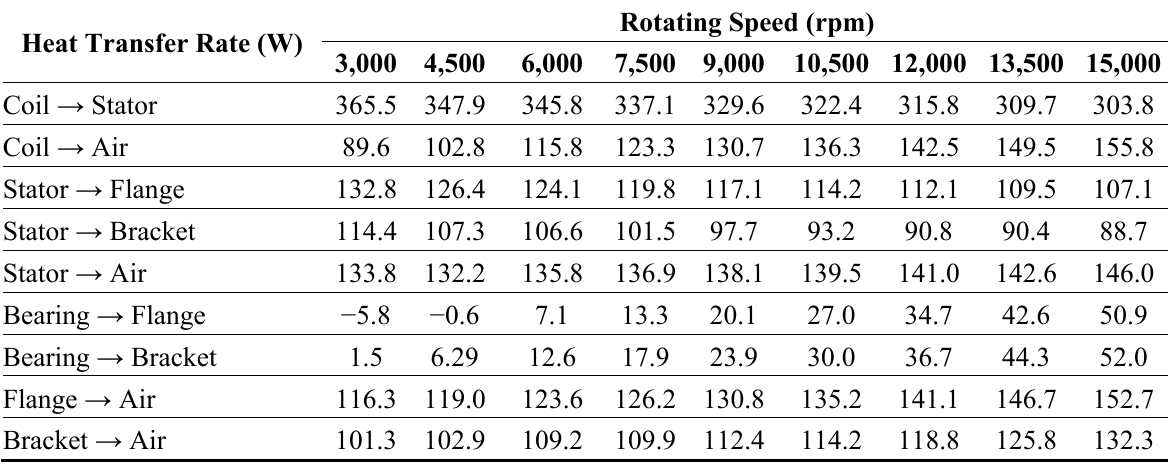
Table 6. Heat transfer rates of each surface with respect to rotating speed (@ 25 